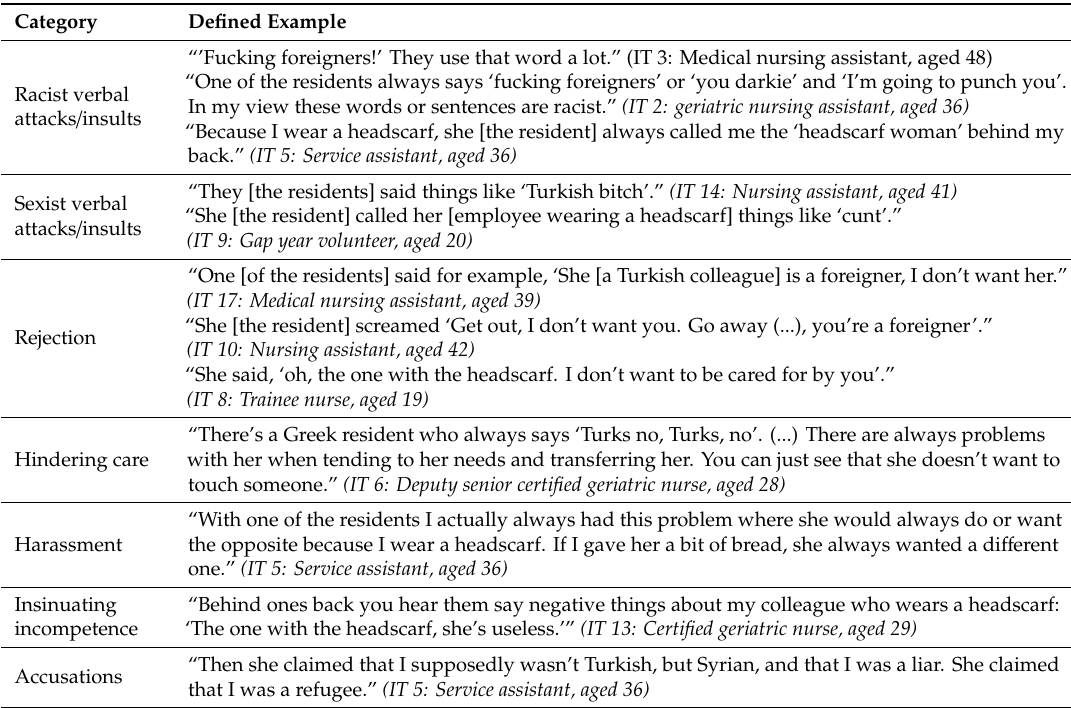
Table 2. Forms of perceived / observed